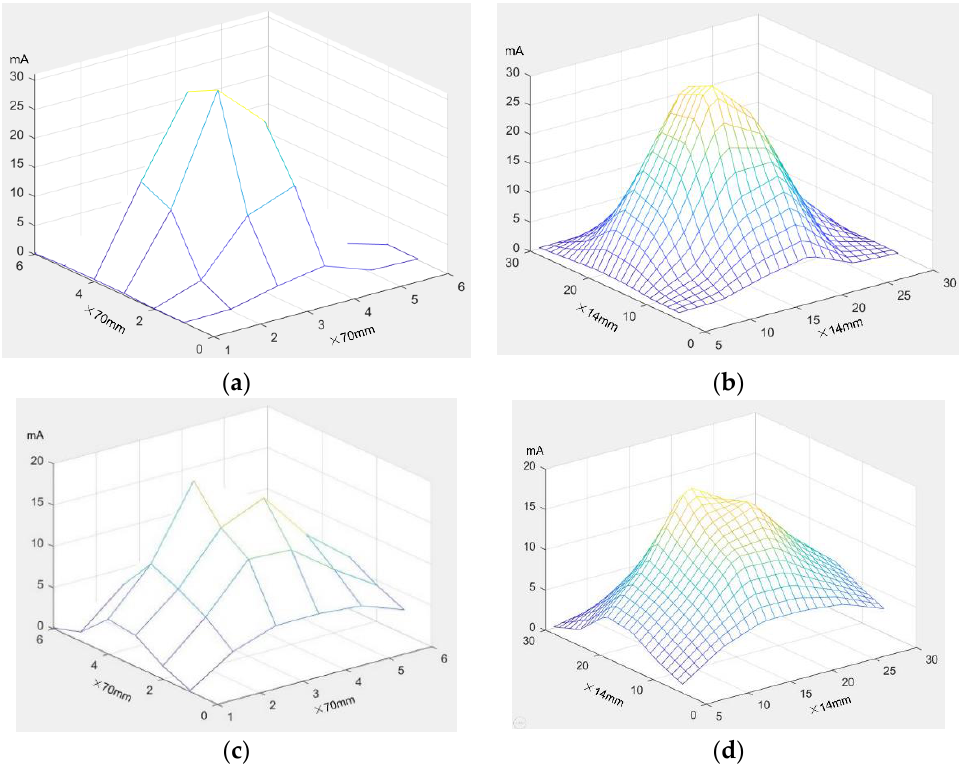
Figure 14. The energy distribution diagram of light spot on photovoltaic panel. ( a ) The original graph under 2 times beam expansion, ( b ) the interpolation graph under 2 times beam expansion, ( c ) the original graph under 4 times beam expansion, and ( d ) the interpolation graph under 4 times beam expansion. Table 7. Voltage and current ration.